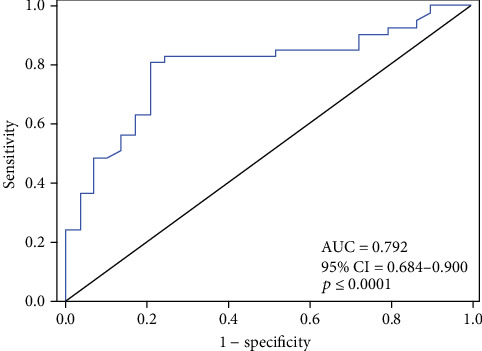
ROC curve analysis for the cytokine-based model in predicting response to bortezomib treatment in MM patients. At the optimal cut-off value of 0.53, the sensitivity and specificity reached 80.5% and 79.3%, respectively.